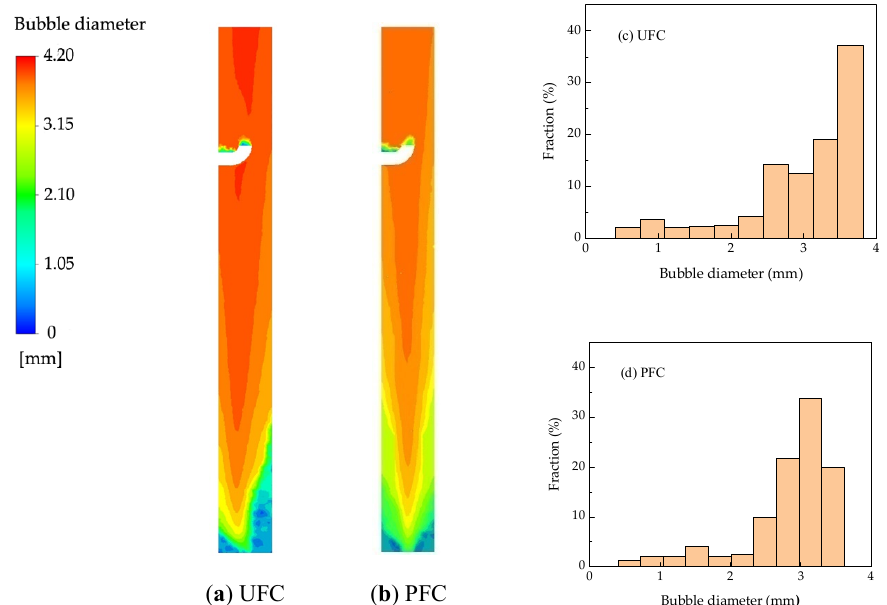
Figure 5. Bubble distribution in UFC and PFC: ( a , b ) Bubble size distribution in specific plane Y = 2mm; ( c , d ) the fractional distribution of bubble size.